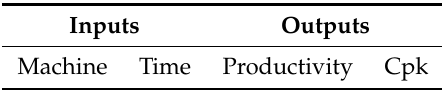
Table 4. DMUs definitions.